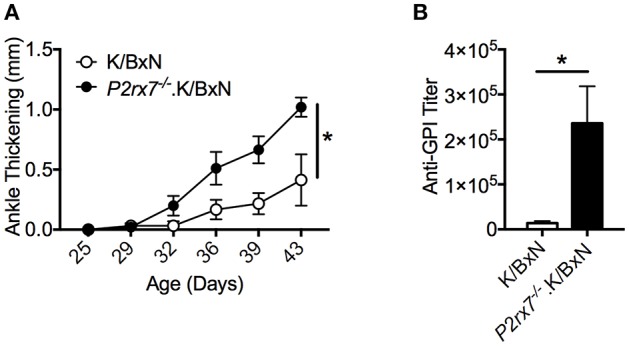
P2RX7 deficiency leads to enhanced disease development in the SFB(–) K/BxN model. (A) Ankle thickness was followed over time for K/BxN and P2rx7−/−.K/BxN mice between ~3.5 and 6 weeks of age. Data are shown as change in ankle thickness compared to first measurement. N = 9–14/group, 6 assays combined. (B) Anti-GPI auto-Ab titers in serum obtained from the end point of each experiment were measured by ELISA. N = 4–8/group, 6 assays combined. Error bars represent SEM. *p < 0.05.